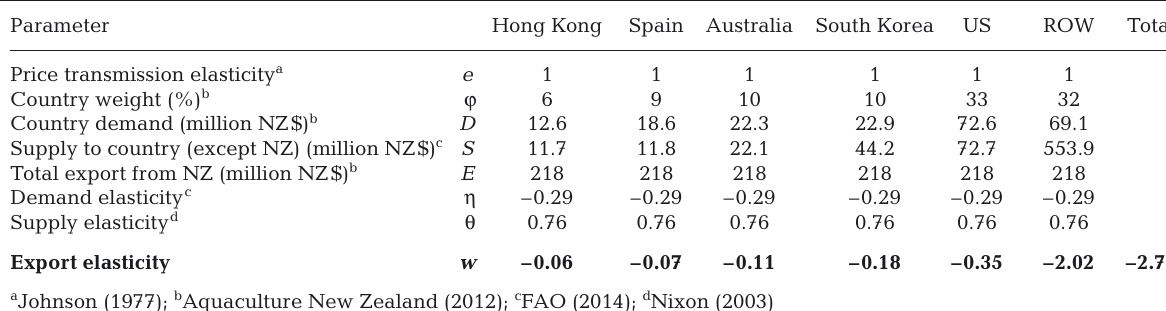
Table A1. Values used to parameterize the export elasticity equation (Eq. A1). ROW: rest of world